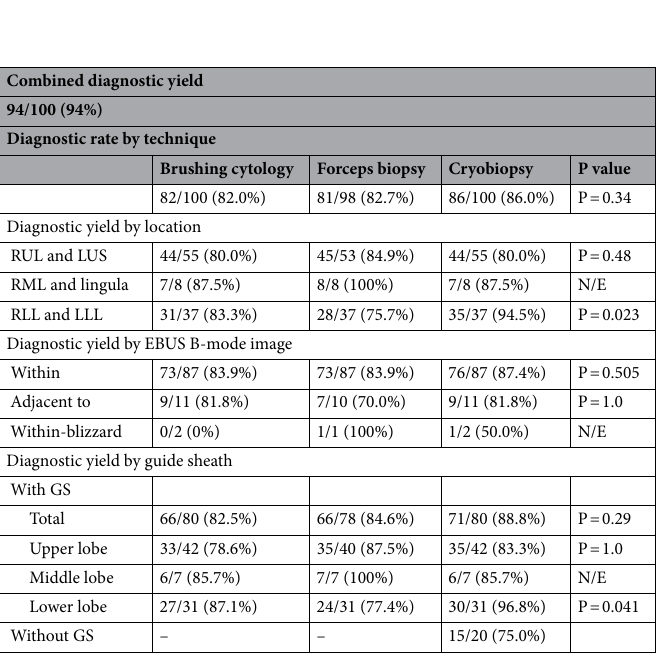
Table 4. Diagnostic yield for each condition. Data are presented as n (%). Two cases did not undergo forceps biopsy at the upper lobe. N/E not evaluated, EBUS endobronchial ultrasonography, GS guide sheath, LLL left lower lobe, LUS left upper segment, RLL right lower lobe, RML right middle lobe, RUL right upper